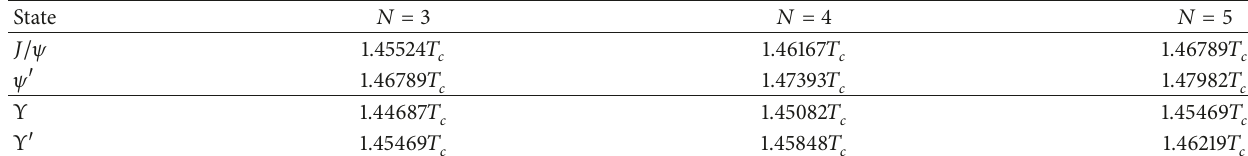
Table 2: The dissociation temperature 𝑇 𝐷 (MeV) at 𝜇 = 0.6 GeV with 𝑇 𝑐 = 185 MeV.